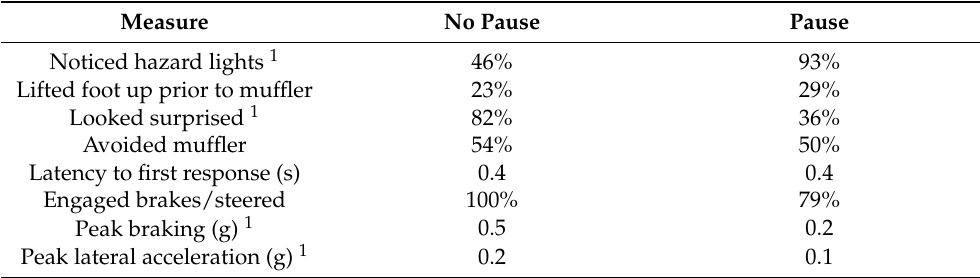
Table 1. Comparison across Pause and No Pause